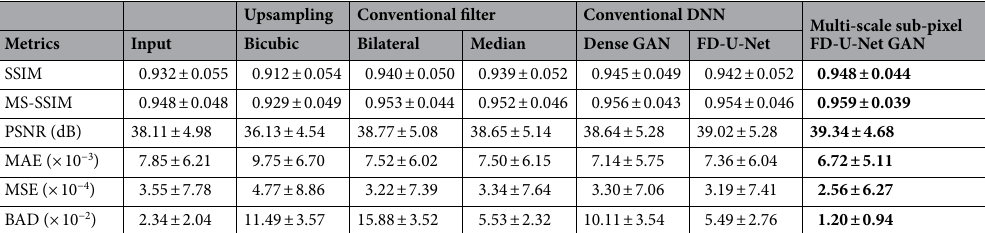
Table 1. Statistical metrics (Mean ± SD) to compare the performances with test set. SSIM structural similarity, MS-SSIM multi-scale structural similarity, PSNR peak signal-to-noise ratio, MAE mean absolute error, MSE mean square error, and BAD blur absolute difference. The top scores are highlighted in